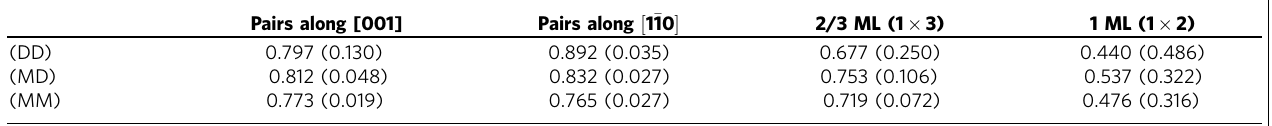
The repulsion energy between the methanol molecules (in eV) is given in brackets. The binding energy for single molecules is 0.927eV (D) and 0.792eV (M). (D, dissociated; M,